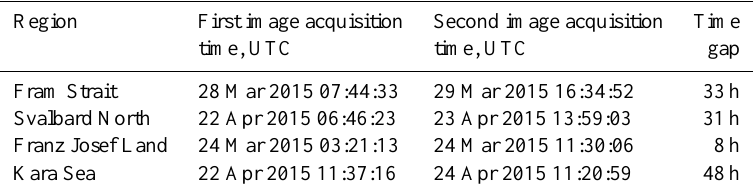
Table 1. Sentinel-1 image pairs used for parameter tuning.